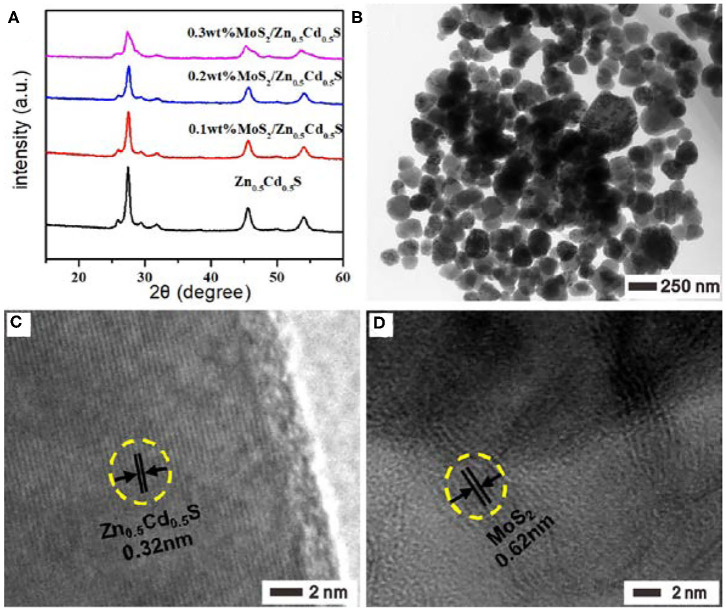
(A) XRD patterns of Zn0.5Cd0.5S, 0.1% MoS2/Zn0.5Cd0.5S, 0.2% MoS2/Zn0.5Cd0.5S, and 0.3% MoS2/Zn0.5Cd0.5S. (B,C) TEM images of 0.2% MoS2/Zn0.5Cd0.5S. (D) TEM images of 1% MoS2/Zn0.5Cd0.5S.